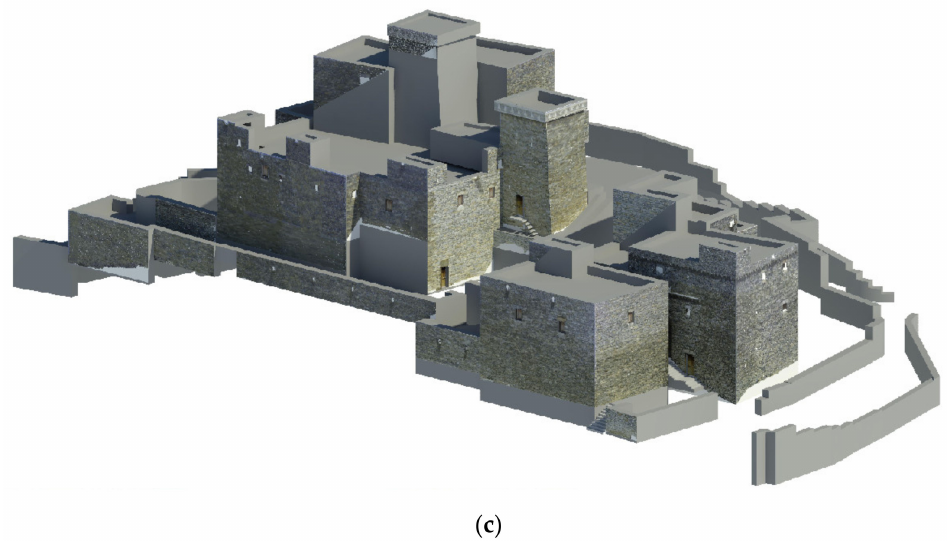
Figure 24. ( a ) Large scale true orthophoto (2 cm GSD) using TLS Camera, the occluded areas in white; ( b ) warping the orthoimage to the corresponding surfaces in Revit environment; ( c ) As-Texture HBIM using different true